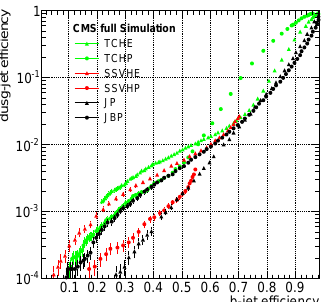
Fig. 5. Performance of all b-taggers obtained on the simulated QCD events. The performance are shown as udsg jets tagging e ffi ciency versus b-jets tagging e ffi ciency.